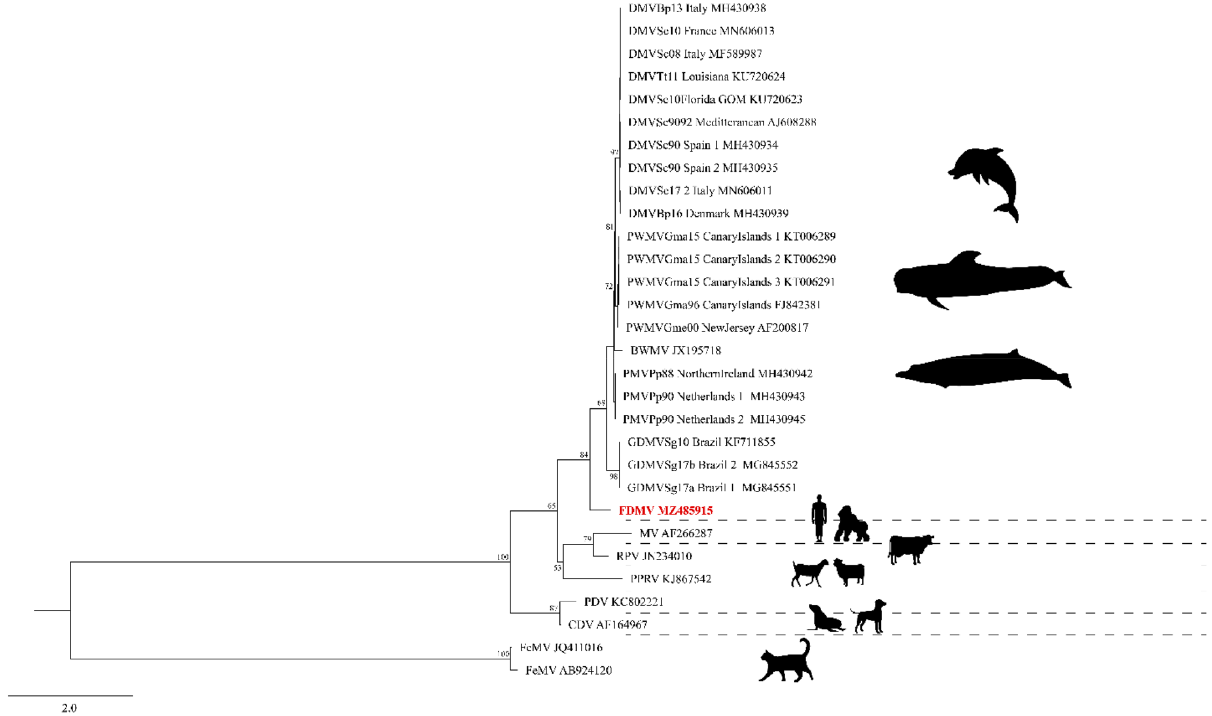
Figure 7. Maximum Likelihood (ML) phylogenetic analysis based on the partial nucleotide (nt) sequences of the P gene. Each sequence is denoted by its strain/isolate name, geographic area of stranding (where available), and GenBank accession number (where available). The phylogeny includes 30 nucleotide sequences with a total of 248 characters (including gaps) in the final dataset. IQ-TREE software (http:// iqtree. cibiv. univie. ac. at/) was used to determine best-fit models and perform ML phylogenetic analysis with 1000 non-parametric bootstraps. The best-fit model for the alignment was TPM2 + G4TPM2u + G4, chosen based on Bayesian